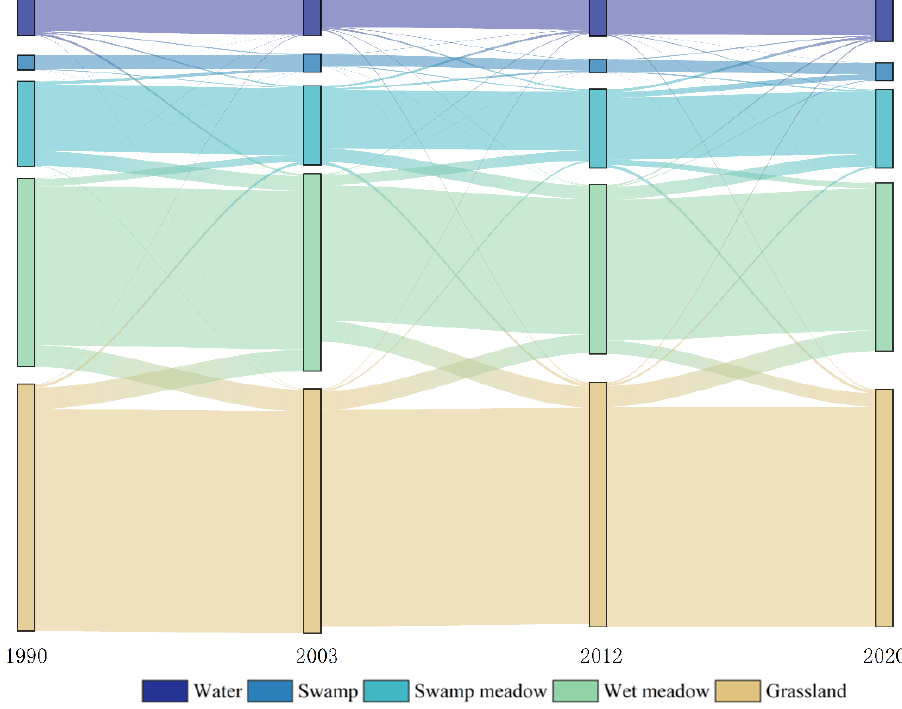
Figure 10. Maqu wetland type transitions from 1990 to 2020.